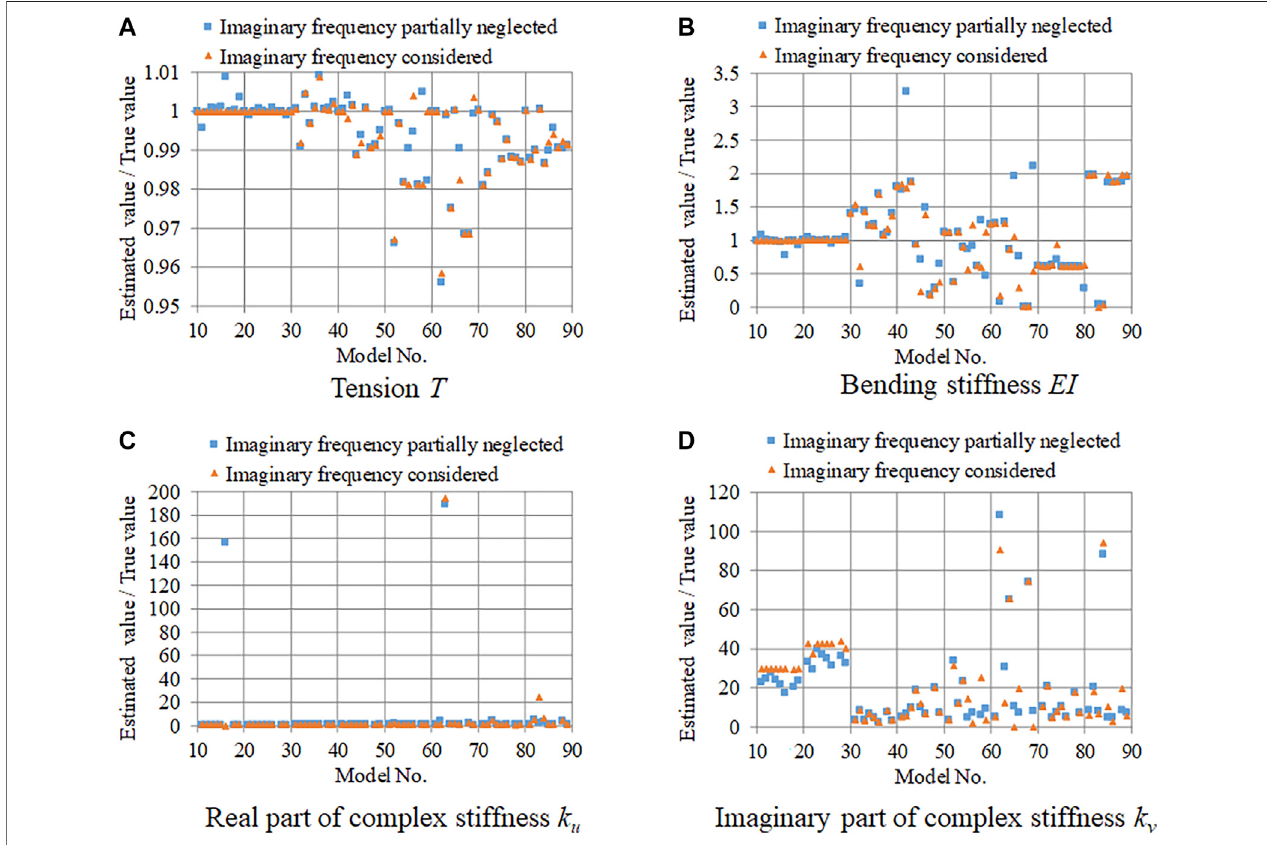
FIGURE 5 | Effect of partially ignoring imaginary part of complex natural frequency in high-damping rubber damper model: (A) tension; (B) bending stiffness; (C) real part of complex stiffness; (D) imaginary part of complex stiffness.